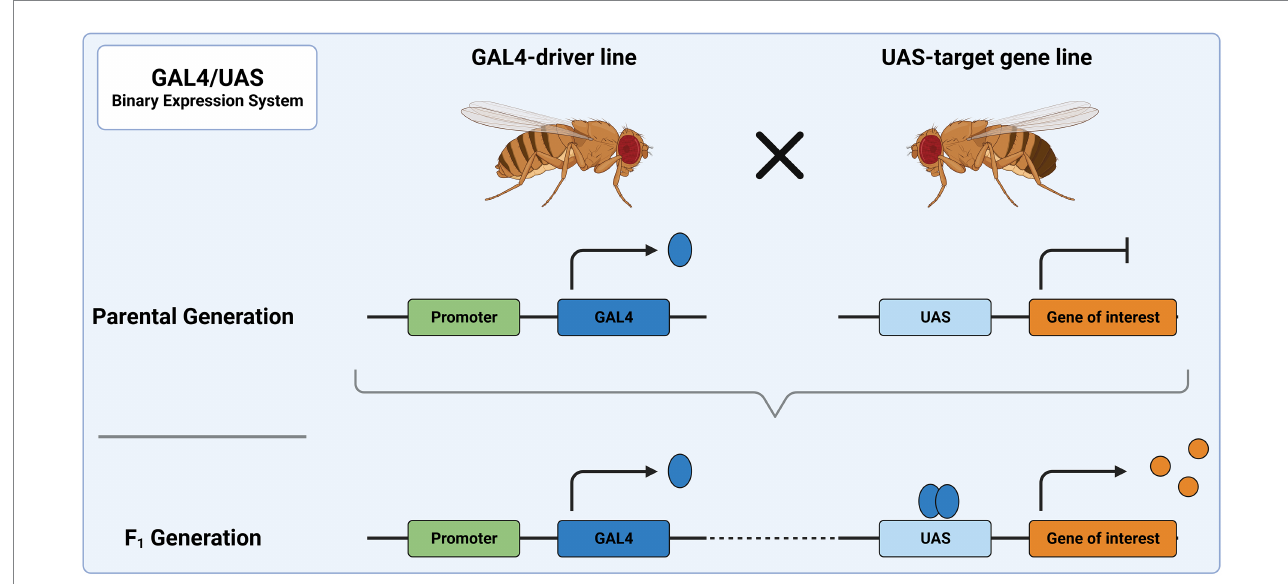
FIGURE 3 The GAL4/UAS system represents the most widely used binary expression system. In the parental generation, one fly carries GAL4 under a specific promoter and the other a genetic sequence downstream of UAS. When these flies are crossed, the progeny will express GAL4 in all tissues, in which the promoter is utilized. There, it acts as a transcription factor and binds to UAS, leading to expression of the downstream